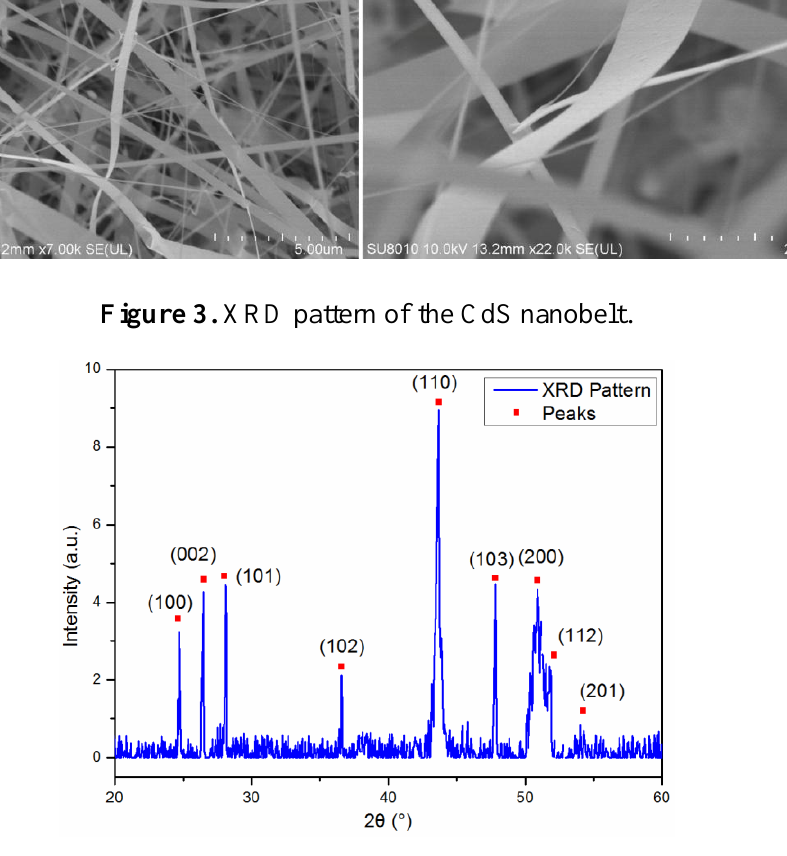
Figure 4. TEM, HRTEM and SAED image of the single CdS